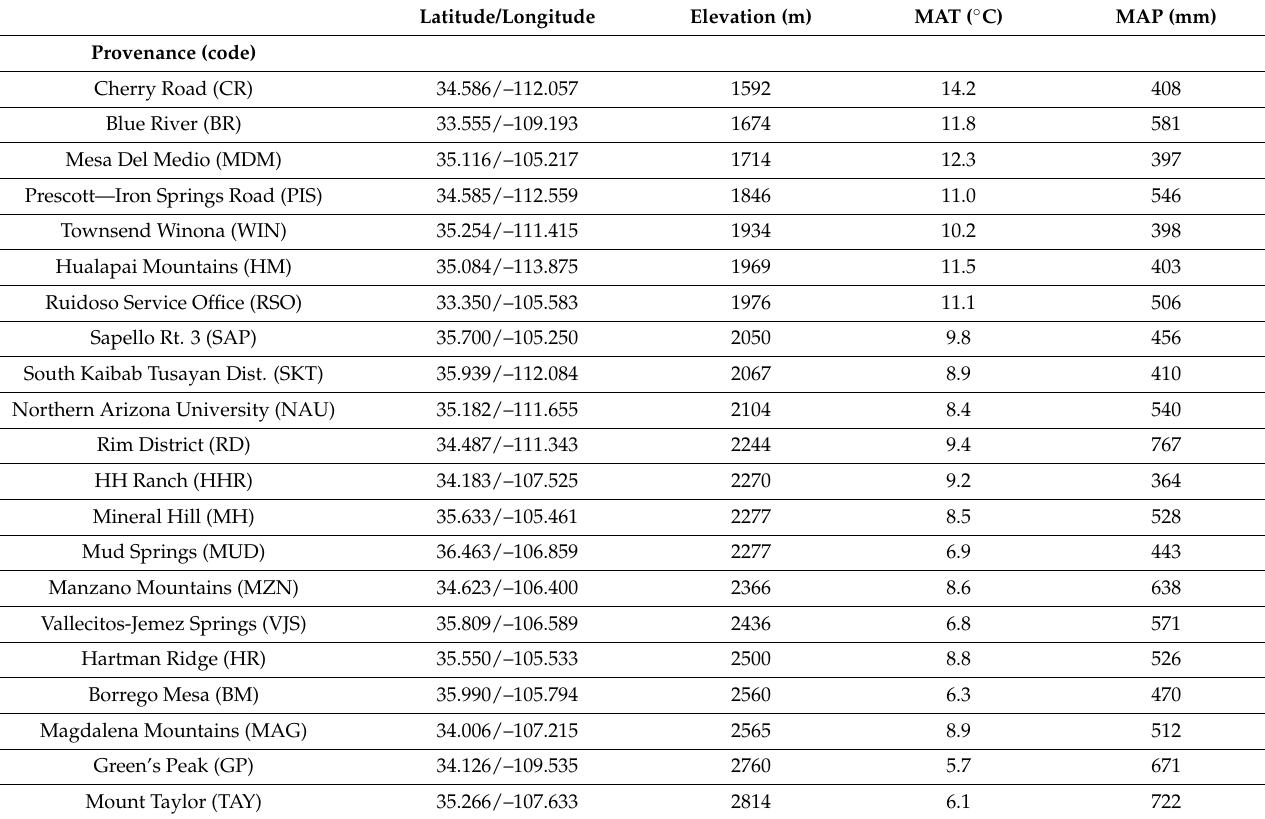
Table 1. Name (code), latitude, longitude, elevation (m a.s.l.), mean annual temperature (MAT), and mean annual precipitation (MAP) for provenances and common garden sites, ordered by increasing elevation. Climate data (30 year normal, 1981–2010) are from PRISM (PRISM Climate Group, Oregon State University, http://prism.oregonstate.edu, created 19 September 2020). Values are means over mother tree locations at each